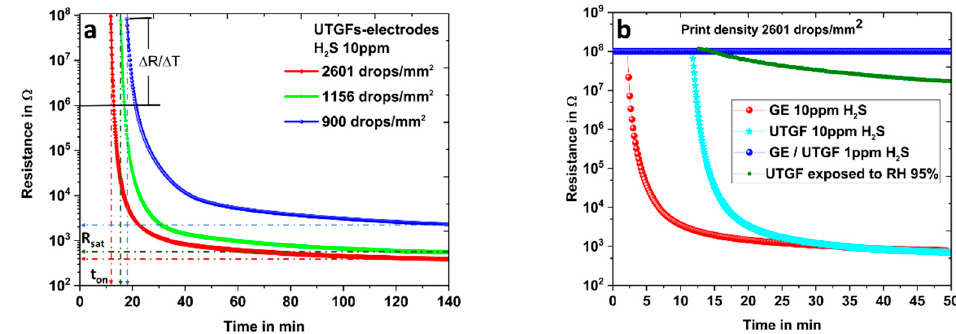
Figure 4. ( a ) The change in resistance of UTGFE comprising of copper acetate-based sensing films with different print densities towards 10 ppm H 2 S as a function of time at room temperature; ( b ) A comparison of the electrical response of UTGFE sensor with GE sensor along with the humidity background of the UTGFE sensor.